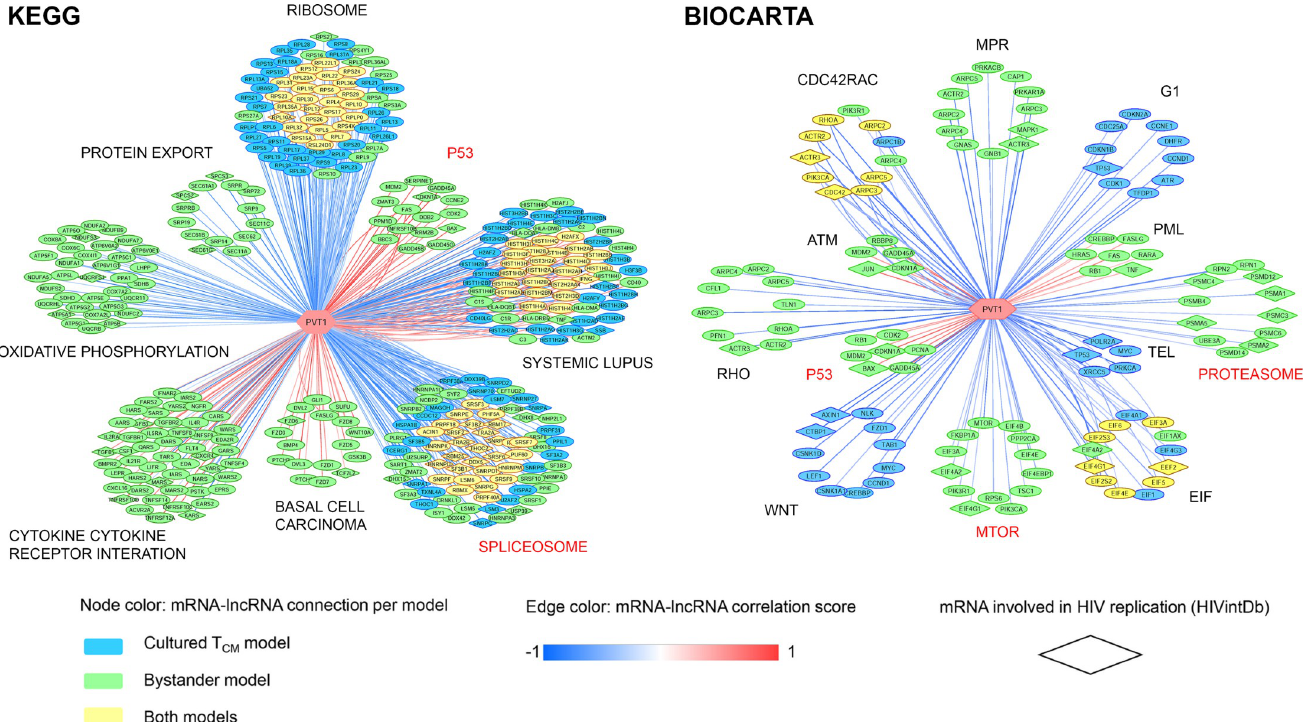
Fig 6. Associations between PVT1 and mRNA components of identified associated KEGG and Biocarta pathways. Output of the guilt-by-association analysis was filtered for PVT1 -specific pathway associations and corresponding leading edge mRNAs (GSEA FDR < 0.05). Next, a matrix with PVT1 -specific information on pathway association, HIV latency model, enrichment score and leading edge mRNAs served as input for Cytoscape visualization (v3.4.0). Associations between PVT1 and mRNAs in all pathways (FDR corrected p < 0.05) are shown. Nodes represent individual mRNAs associated with PVT1 and are color coded by model of HIV latency: blue , cultured T CM model, green , bystander model, and yellow , common association for both models. Nodes in a shape of a rhombus indicate mRNAs involved in HIV replication (annotated in the NCBI HIV-1 Interaction Database, HIVintDb ). The color of the lines connecting PVT1 to mRNAs indicate correlation ( red , positive; blue , negative). Names of pathways implicated in HIV latency are indicated in red